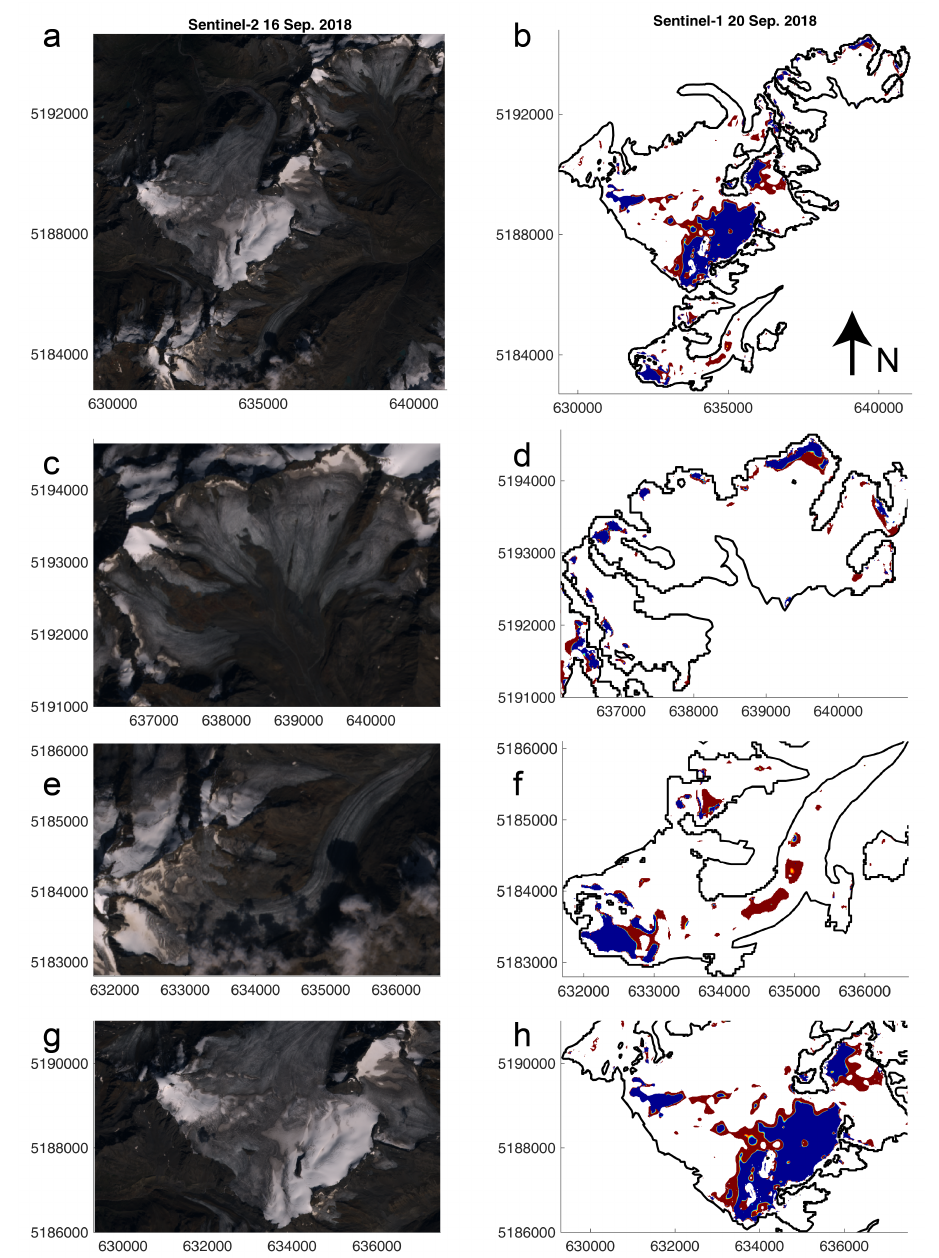
Figure 7. Comparison of Sentinel-2 (S2) optical data showing firn and snow patches with Sentinel-1 (S1) derived wet snow covered area fraction maps for all areas of interest (AOIs) and for each AOI respectively. The color coding is constantly displaying derived firn (red) and wet snow (blue) areas for all presented S1 data. S2 imagery was recorded at 16 September 2018 and S1 data at 20 September 2018. S2 imagery ( a ), S1 analysis presenting all three AOIs ( b ), zoom for AOI Vernagtferner with optical ( c ) and S1 data ( d ), zoom for AOI Hintereisferner with optical ( e ) and S1 data ( f ), zoom for a fraction of AOI Gepatschferner with optical ( g ) and S1 data ( h ). Coordinates are given in UTM with datum WGS 1984. All maps are aligned equally.